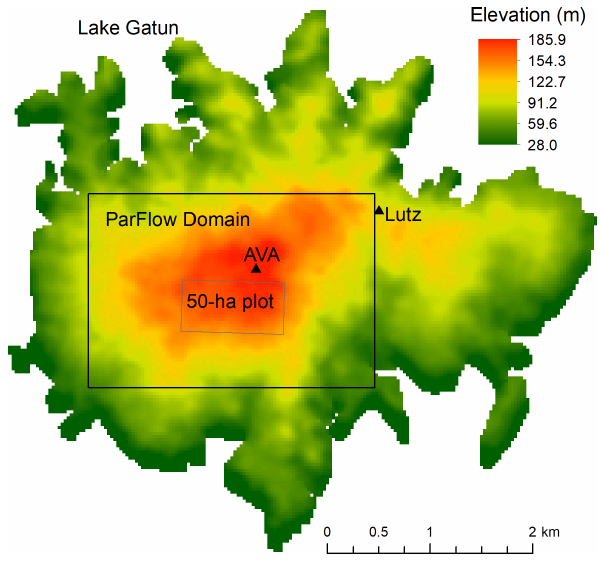
Figure 2. Simulation domain and elevation. The black rectangle in- side is the ParFlow simulation domain, and the smaller grey rectan- gle indicates the 50ha census plot on the highland. Locations of the AVA eddy-covariance tower and the Lutz meteorological tower are shown by the small